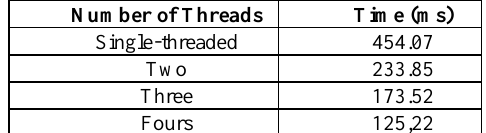
Table 2. Number of threads enabled and total rendering time until the 3D mesh is